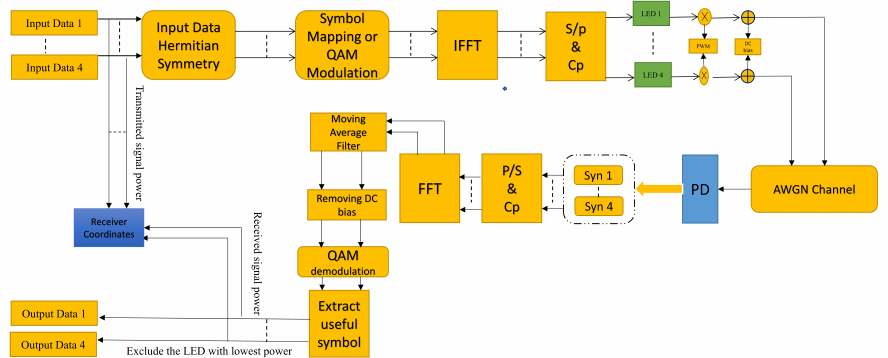
Figure 5. OFDM transmitter and receiver configuration for both communication and position- ing